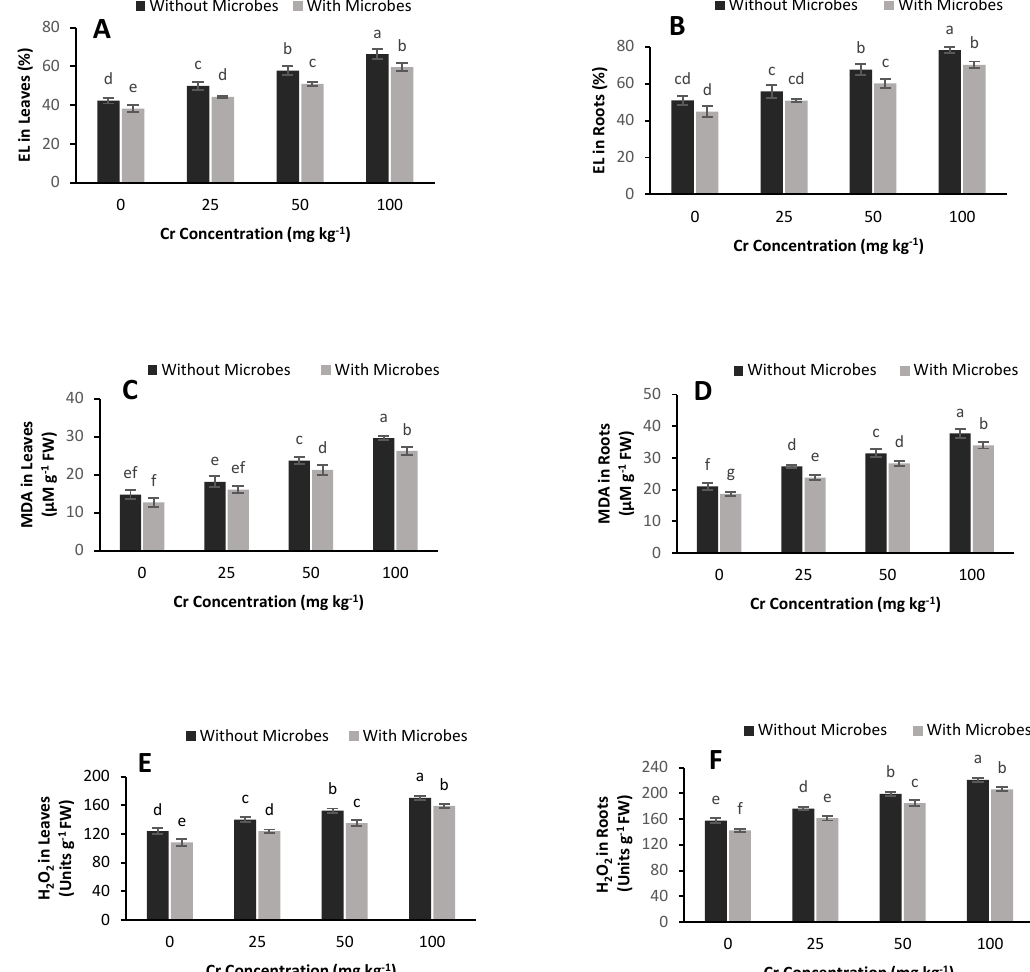
Figure 4. Influence of the di ff erent Cr levels (0, 25, 50, 100 mg · kg − 1 ), with and without peat-moss-based microbial inoculation, on EL in leaves ( A ), EL in roots ( B ), MDA in leaves ( C ), MDA in roots ( D ), H 2 O 2 in leaves ( E ) and H 2 O 2 in roots ( F ) of wheat plants. Bars indicate the mean values and standard deviation of three replicates. Di ff erent bar letters show significant changes among various treatments at p < 0.05.